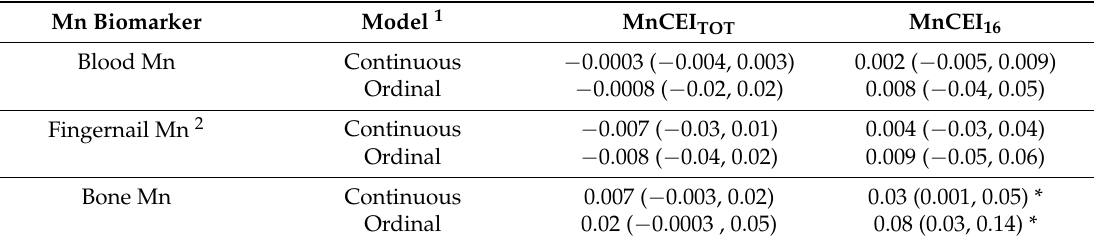
Table 3. The β (95% confidence interval) for MnCEI TOT or MnCEI 16 in adjusted regression models predicting manganese biomarkers, N =